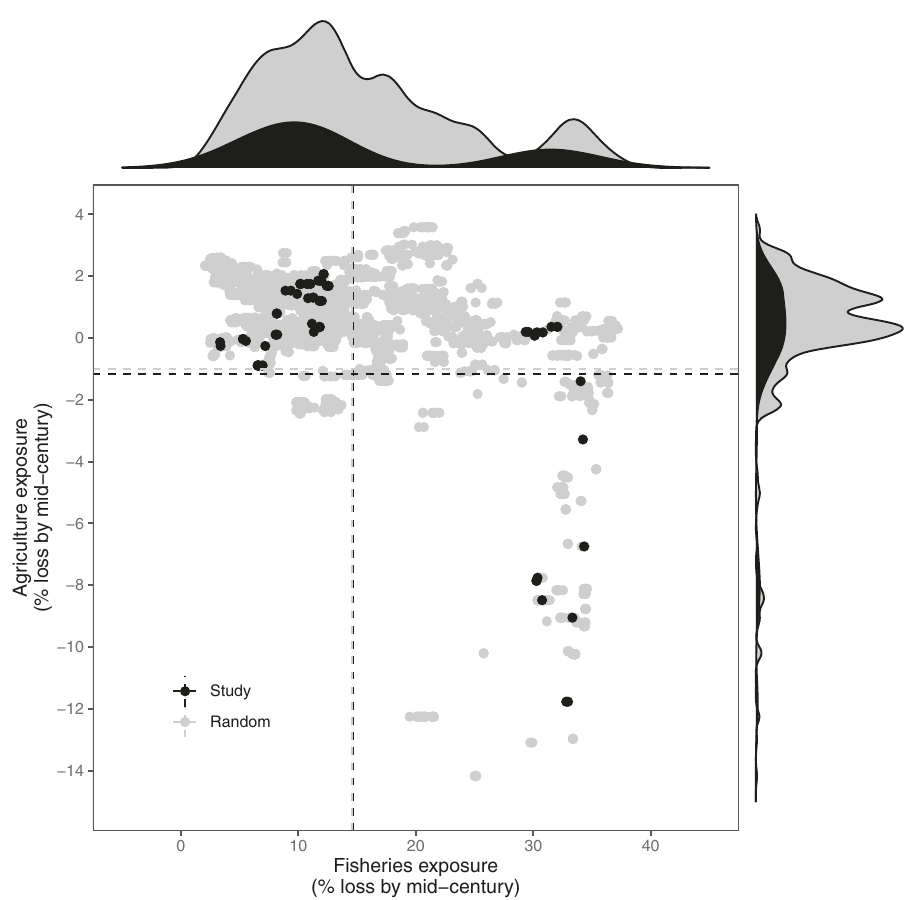
Fig. 2 A comparison of expected fi sheries catch potential and agriculture losses (exposure) by mid-century under SSP5-8.5. Black dots, histograms, and dotted lines (for mean exposures) represent our study sites ( n = 72). Grey dots, histograms, and dotted lines represent a random selection of 10% of coastal cells with population densities >25 people/km 2 from our study countries ( n = 4746).